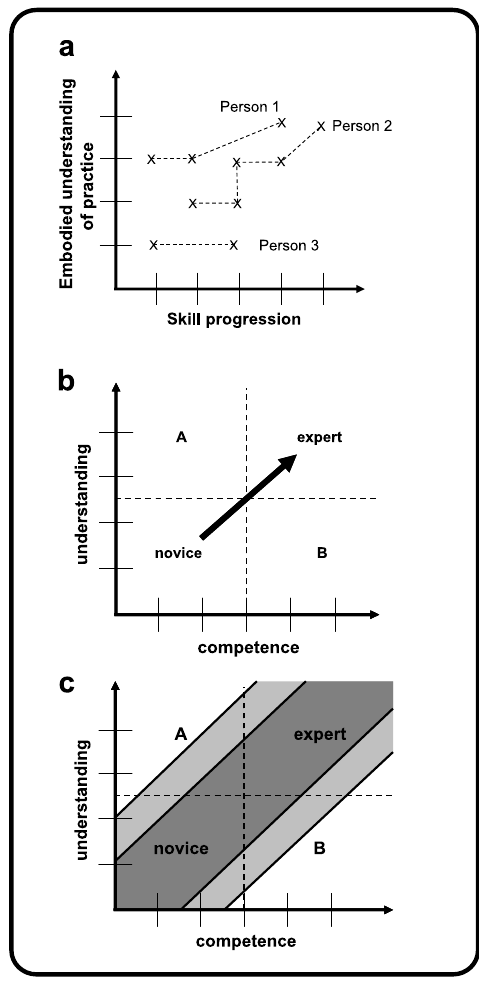
Figure 1. Developing the work of Dall’Alba and Sandberg